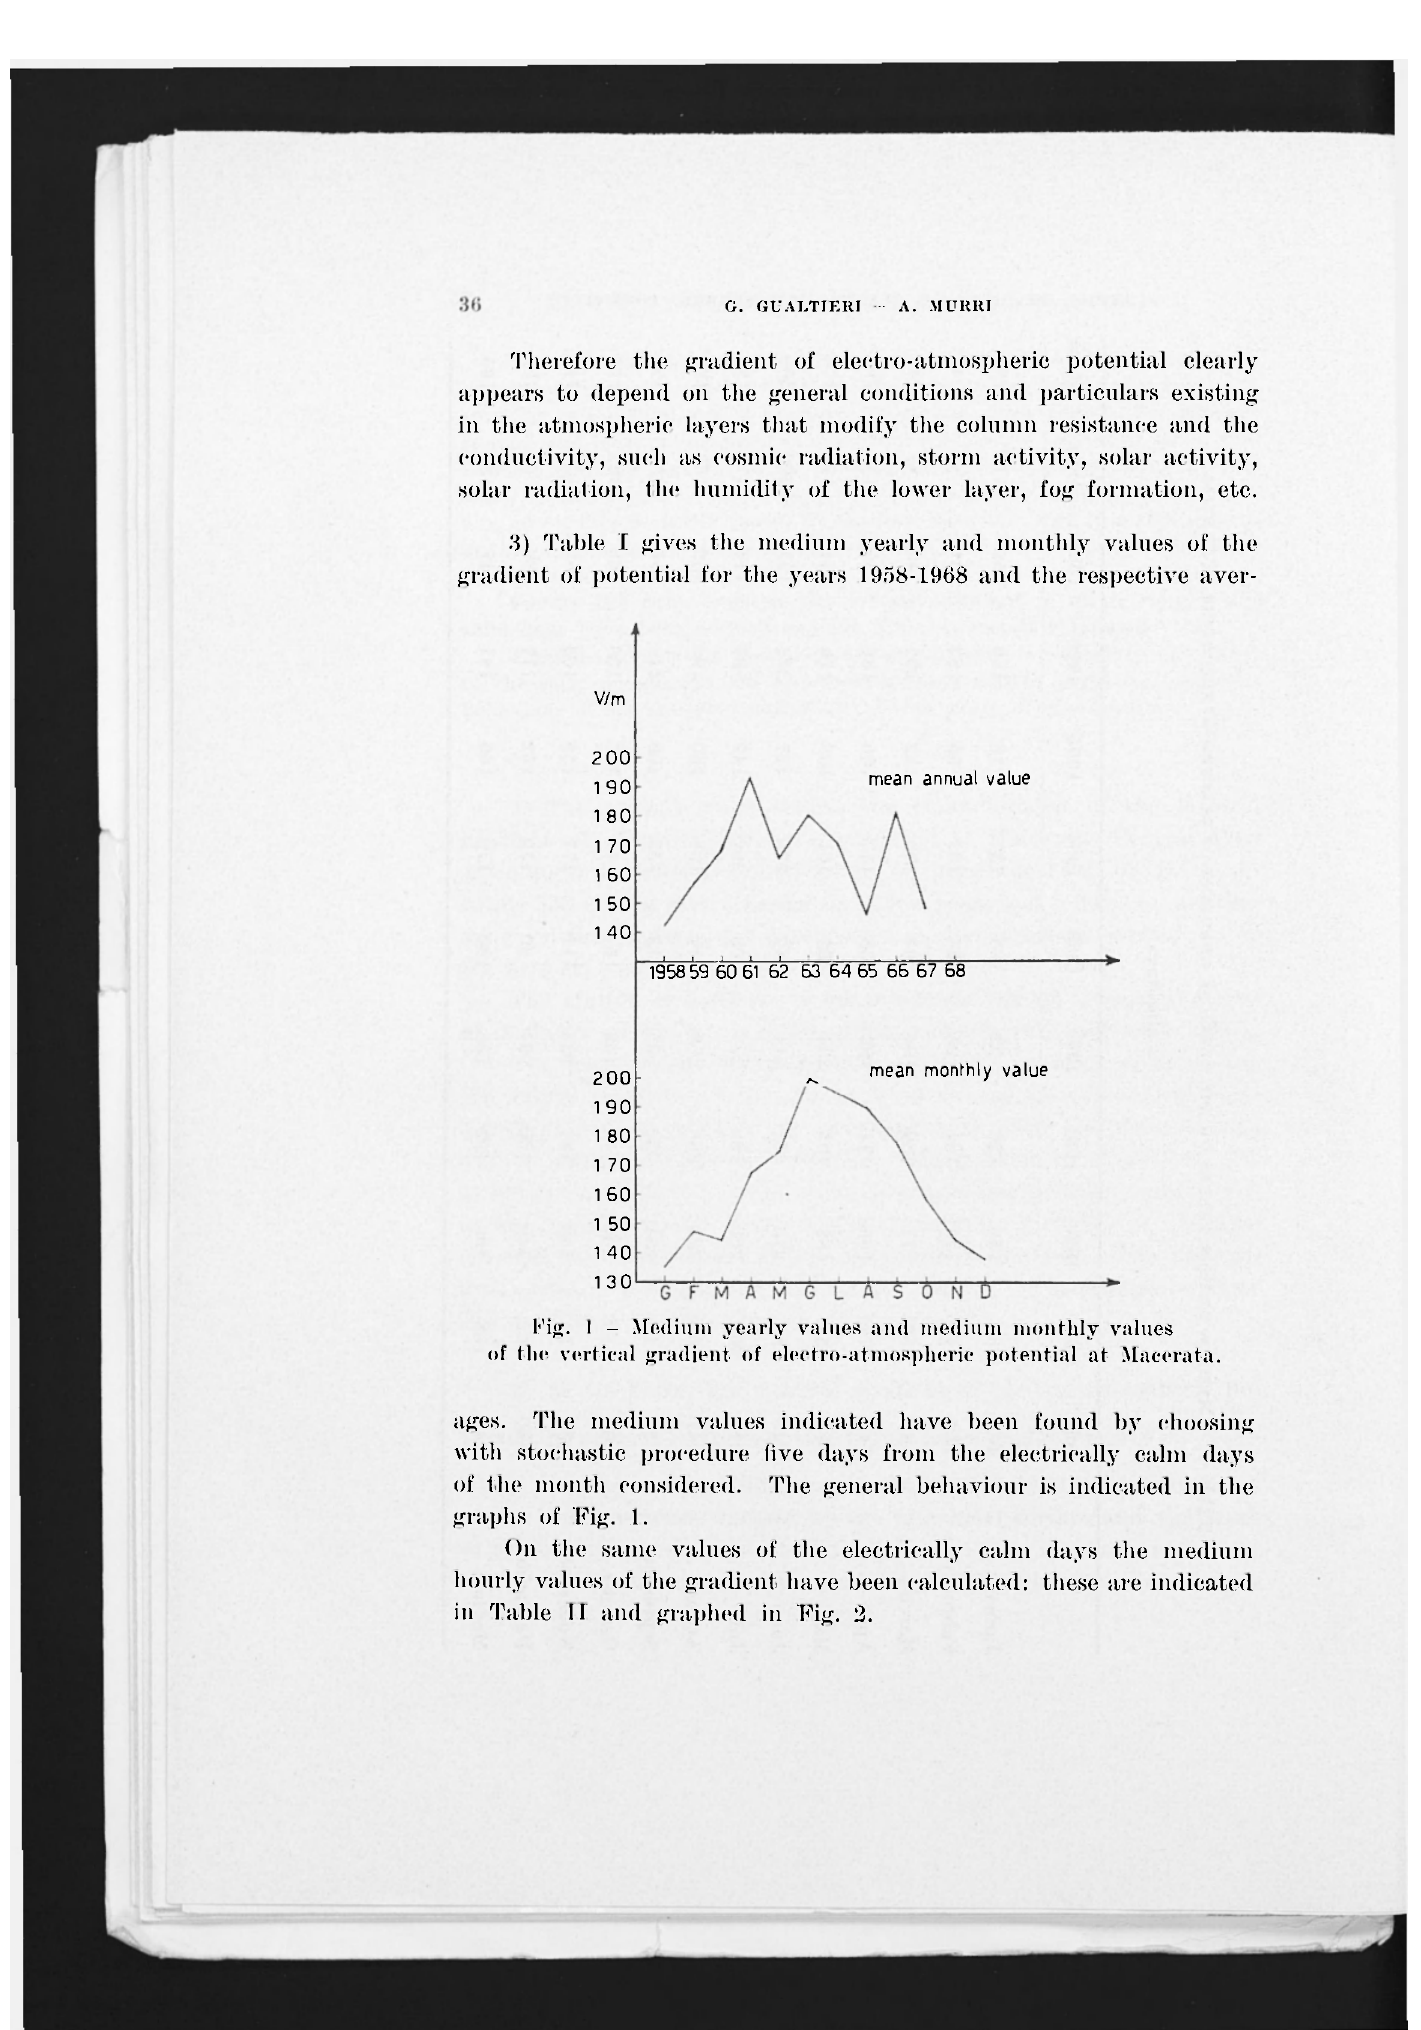
Fig. 1 - Medium yearly values and medium monthly values of the vertical gradient of electro-atmospheric potential at Macerata.